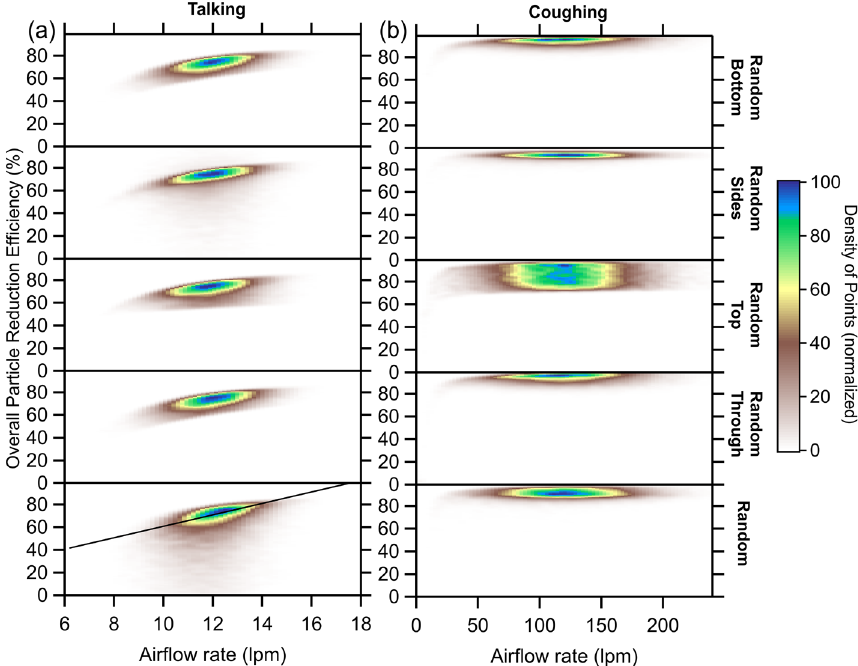
Figure 6. Two-dimensional histograms of the calculated overall particle reduction efficiency for the mask versus the total expiratory airflow rate for ( a ) talking and ( b ) coughing for the five different simulations. Colors indicate the density of individual simulation results (brown = low density, blue = high density).